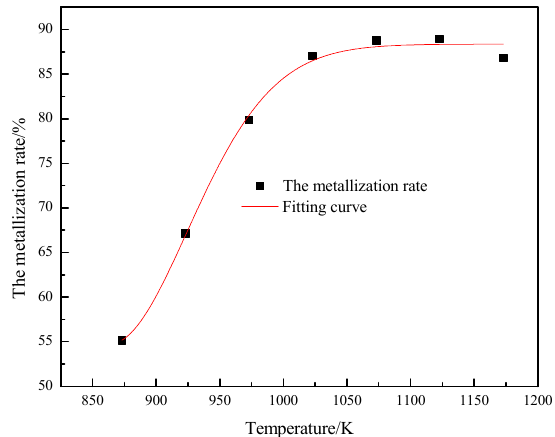
Figure 7. Metallization rate changes with temperature.